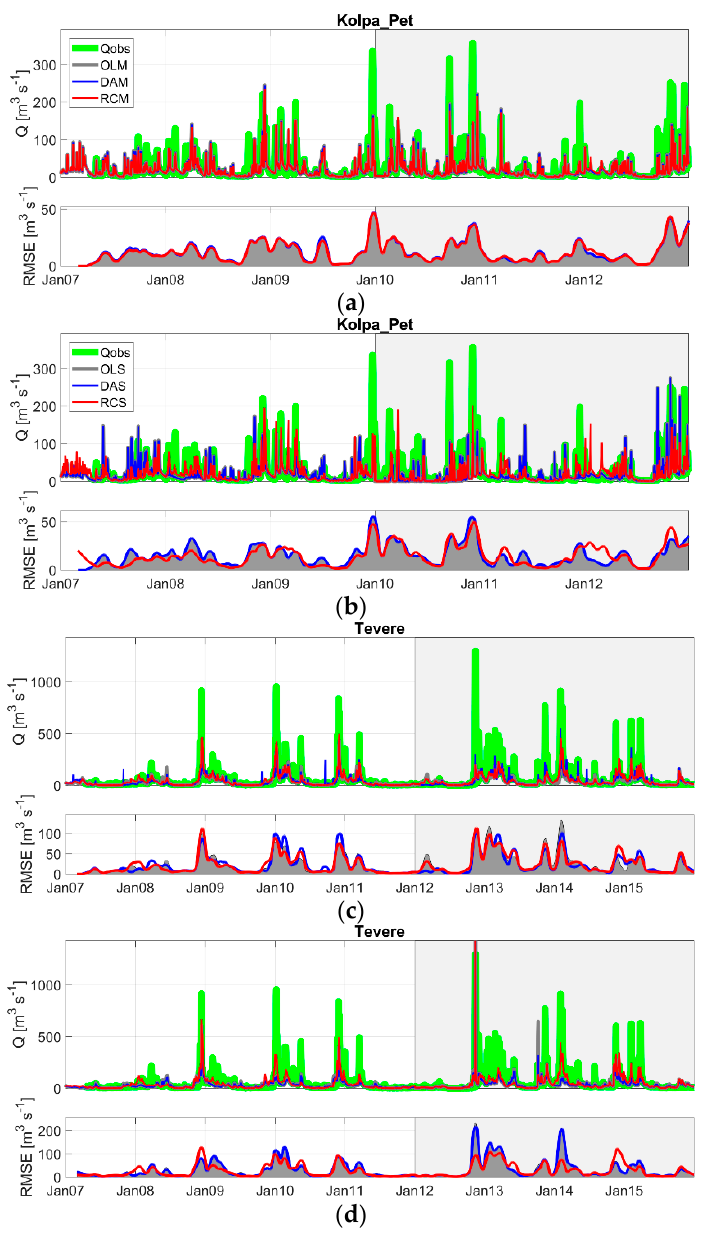
Figure 7. Stream flow simulations in the calibration and validation period for Kolpa-Pet (panels a , b ) and Tevere (panel c , d ) catchments. For each catchment, the results for OLM, OLS, DAM, DAS, RCM and RCS are shown. In each panel, the upper plot shows the comparison in terms of stream flow while the bottom one shows the smoothed time series of the RMSE (by using a moving windows of 60 days for sake of visualization) between observed ( Q obs ) and the three simulated stream flow. The white background refers to the calibration period and the grey background to the